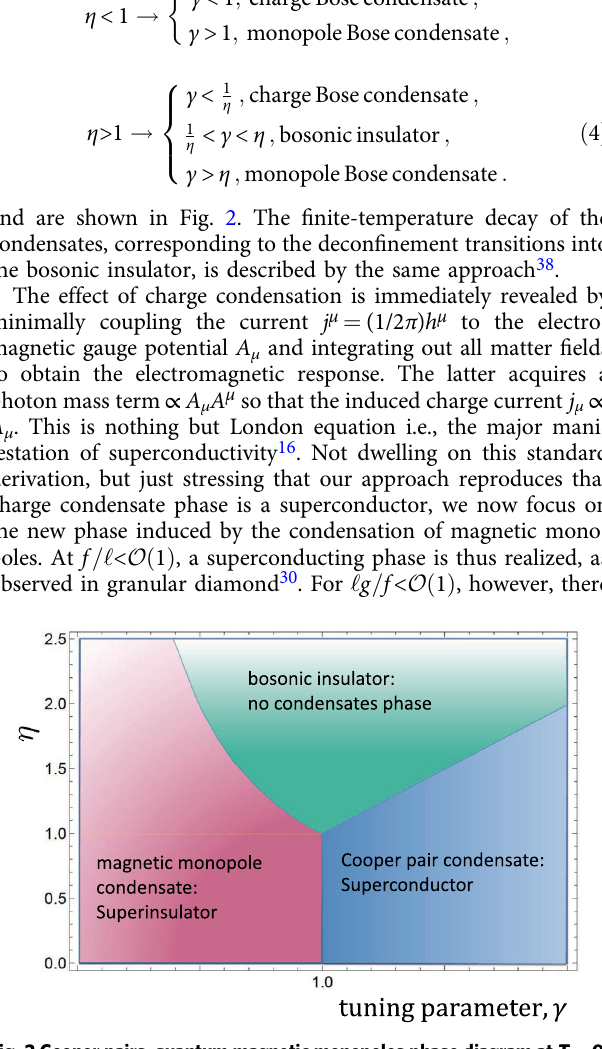
ffiffiffiffiffiffiffiffiffiffiffi p μ μ encodes the strength of quantum N A